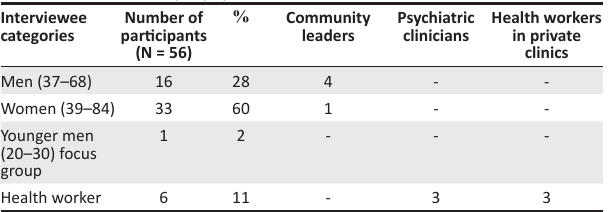
TABLE 1: Research sample